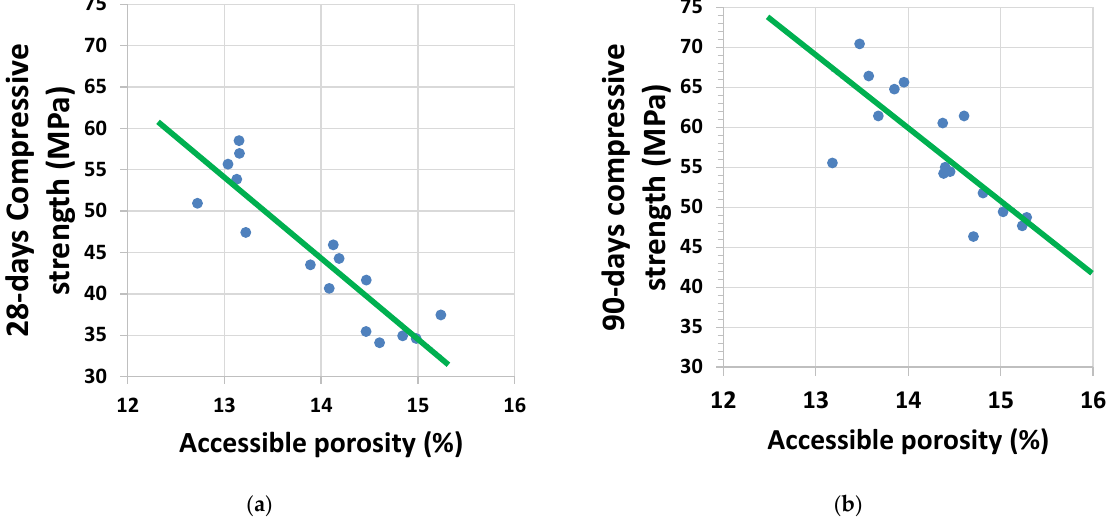
Figure 13. Accessible porosity of mortars versus compressive strength at: ( a ) 28 days; ( b ) 90 days. The study shows that there is a relatively good correlation (R 2 = 0.8067) between the accessible porosity and compressive strength at 28 days (Equation (2)). However, the cor- relation over a longer period of 90 days is worse (R 2 = 0.5786) (Equation (3)). Accessible porosity (%) = − 9.584 × Compressive strength (MPa) + 178.52, (2) Accessible porosity (%) = − 8.8637 × Compressive strength (MPa) + 183.97, (3) Accordingly, the compressive strength of the mortar is closely related to the pore characteristic parameters [30]. In addition, no difference between the coal fly ash or coal bottom ash was found with respect to the effective porosity of mortars, either at 28 days